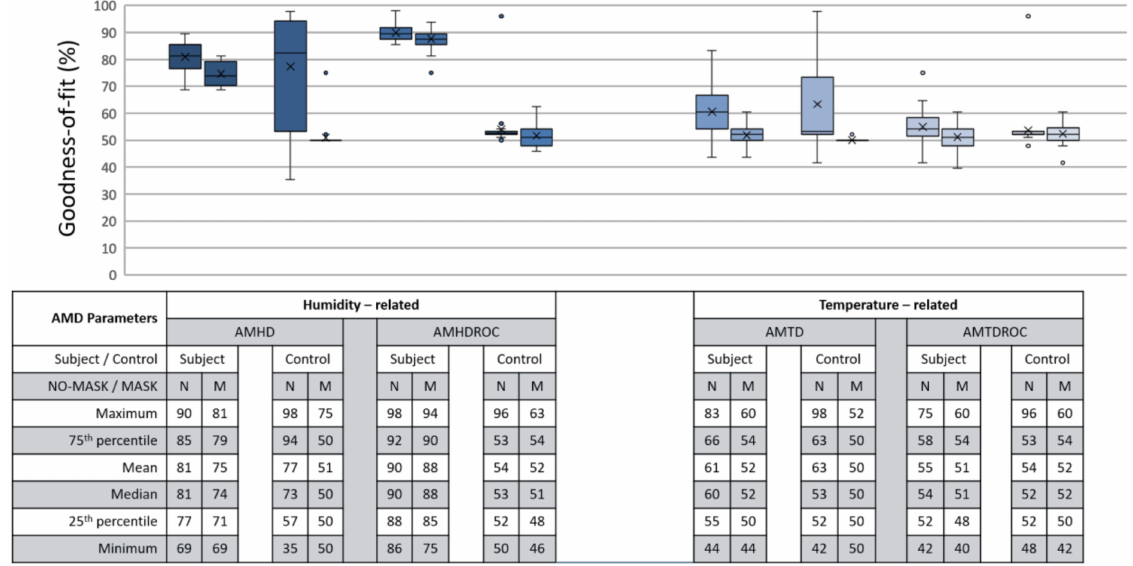
Figure 13. A typical ambient-microclimate humidity difference (AMHD) calibrated logistic regression model from a human subject under NM condition. Red line represents resulting LR function with decision threshold of − 6% RH. Black dots represent NW datapoints associated to Helmet State = 0 and W to Helmet State = 1. The insert is the machine learning LR model as shown in Figure 1.